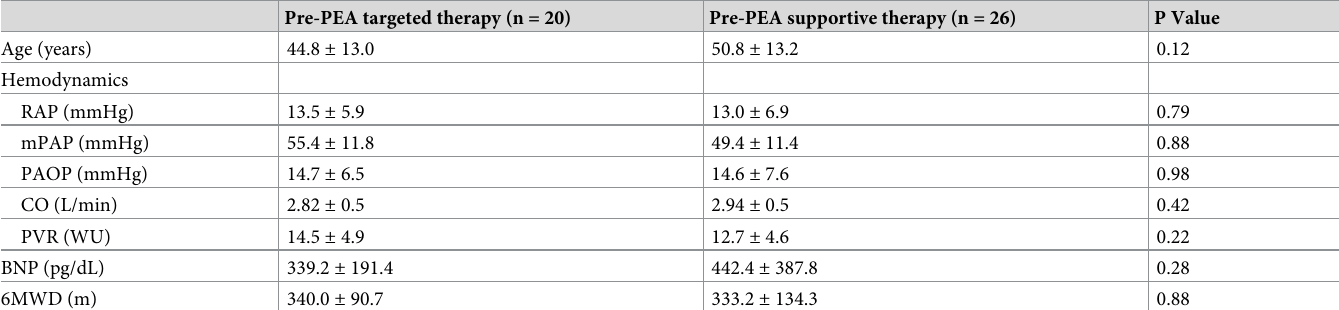
Table 4. Baseline characteristics of patients with low cardiac output according to the use of targeted therapies.